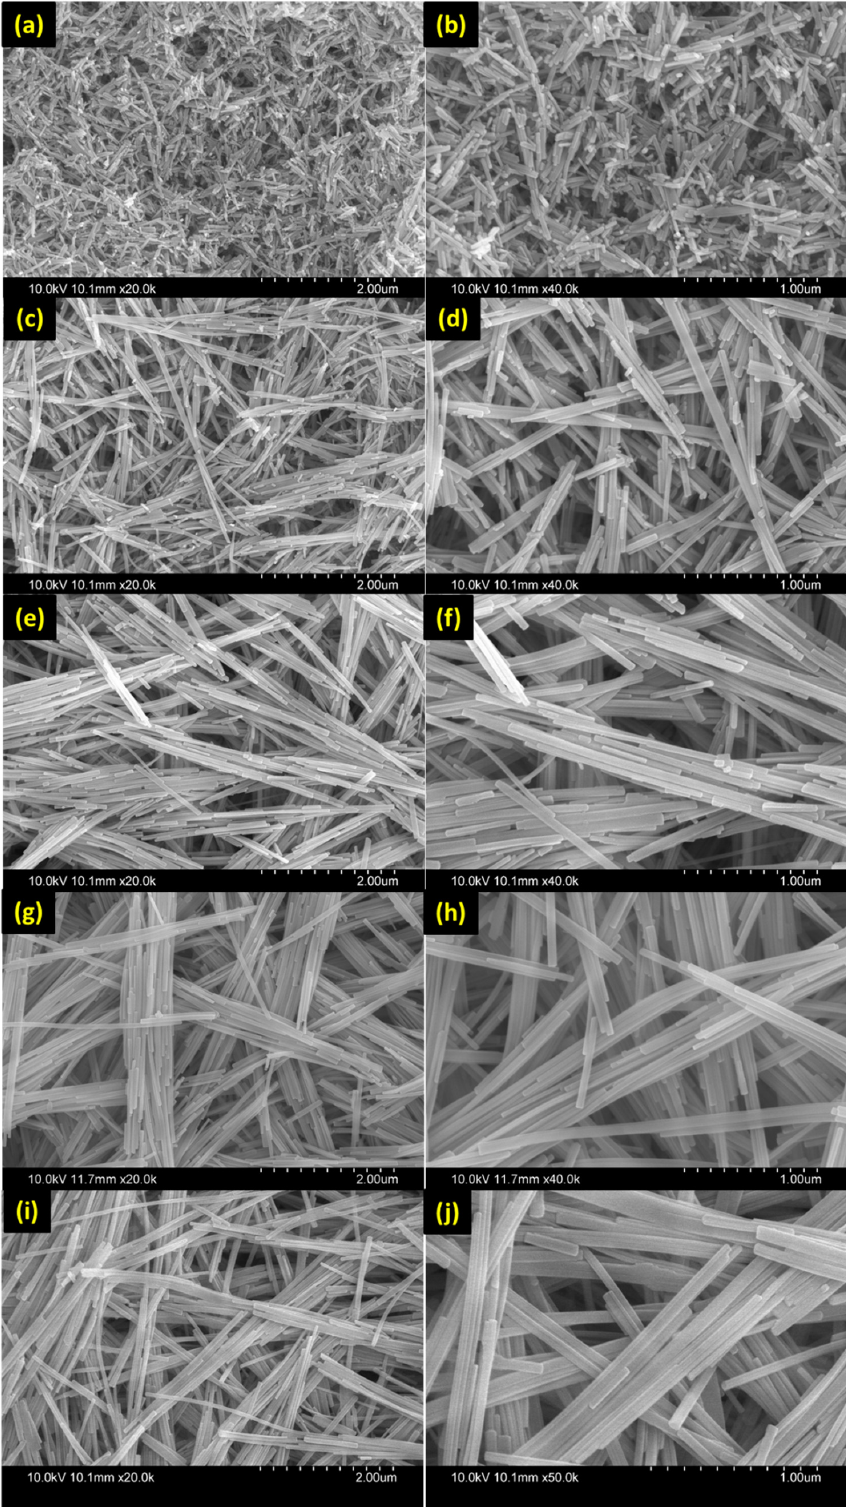
Figure 1. FE-SEM images of as prepared CdS nanorods at a reaction times of 6 h ( a , b ), 12 h ( c , d ), 18 h ( e , f ), 24 h ( g , h ), and 48 h ( i , j